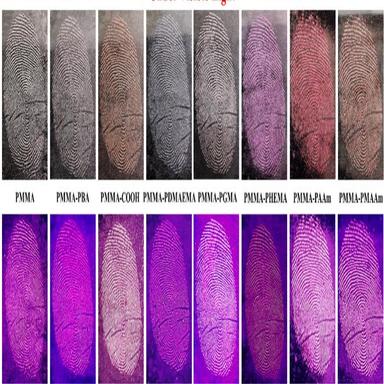
Visualization of latent fingerprints using photoluminescent polymer nanoparticles and powder dusting method.